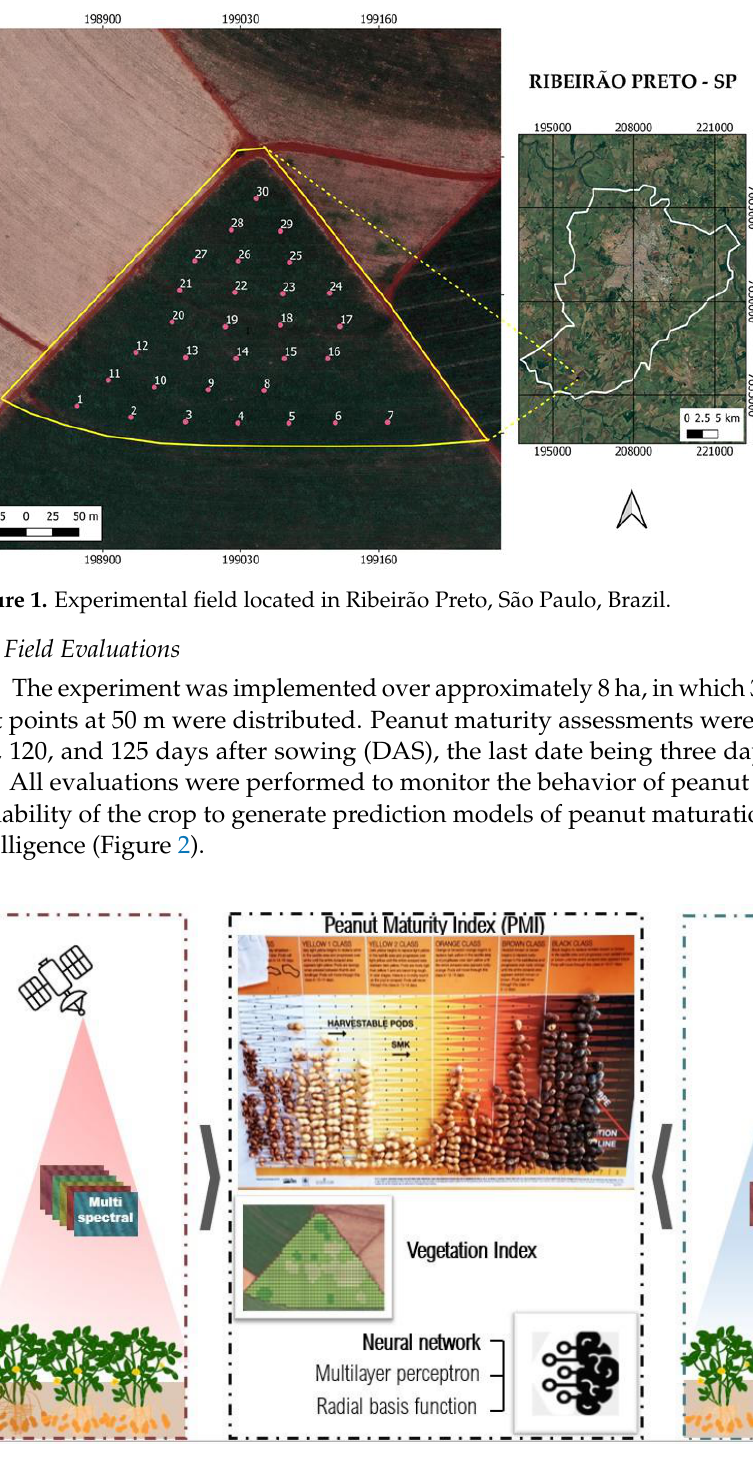
Figure 2. The summarized methodology used to create the non-destructive models to predict peanut maturity index using neural networks and remote sensing.